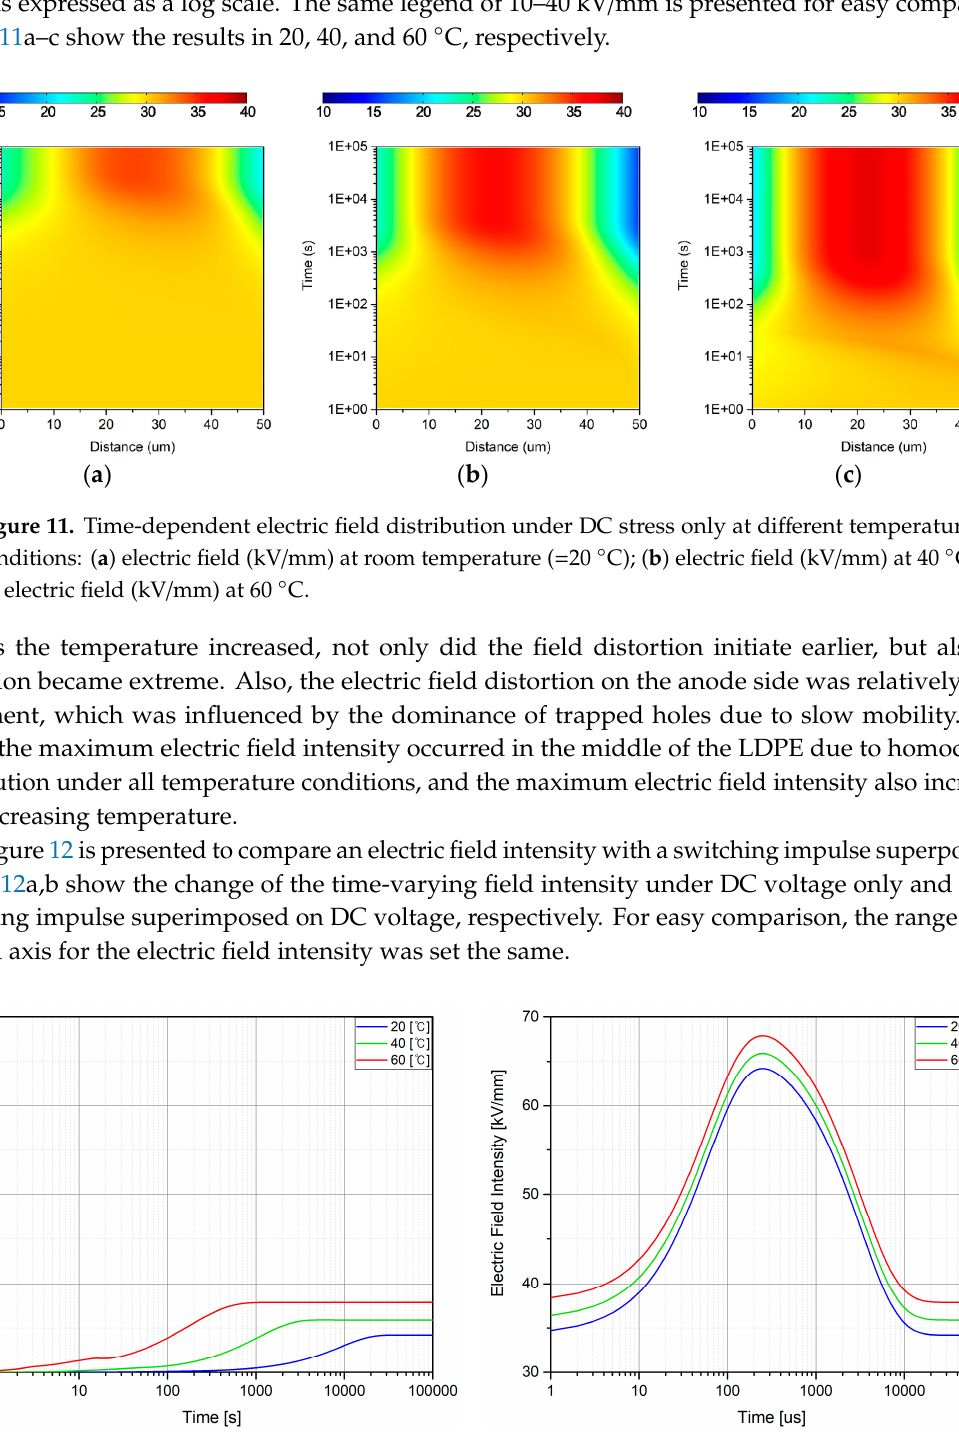
Figure 12. Comparison of current density according to superposition of switching impulse at different temperature conditions: (a) under DC voltage only; (b) under switching impulse superimposed on prestressed DC voltage.